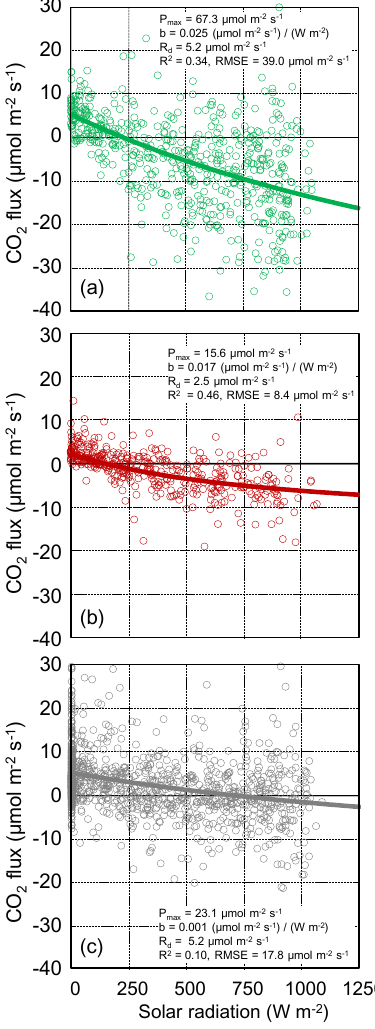
Figure 5. Relationships between the CO 2 flux and solar radiation measured at (a) the urban park in IZM, (b) the rural area in IZM, and (c) OPU sites during the period from July to September 2015.